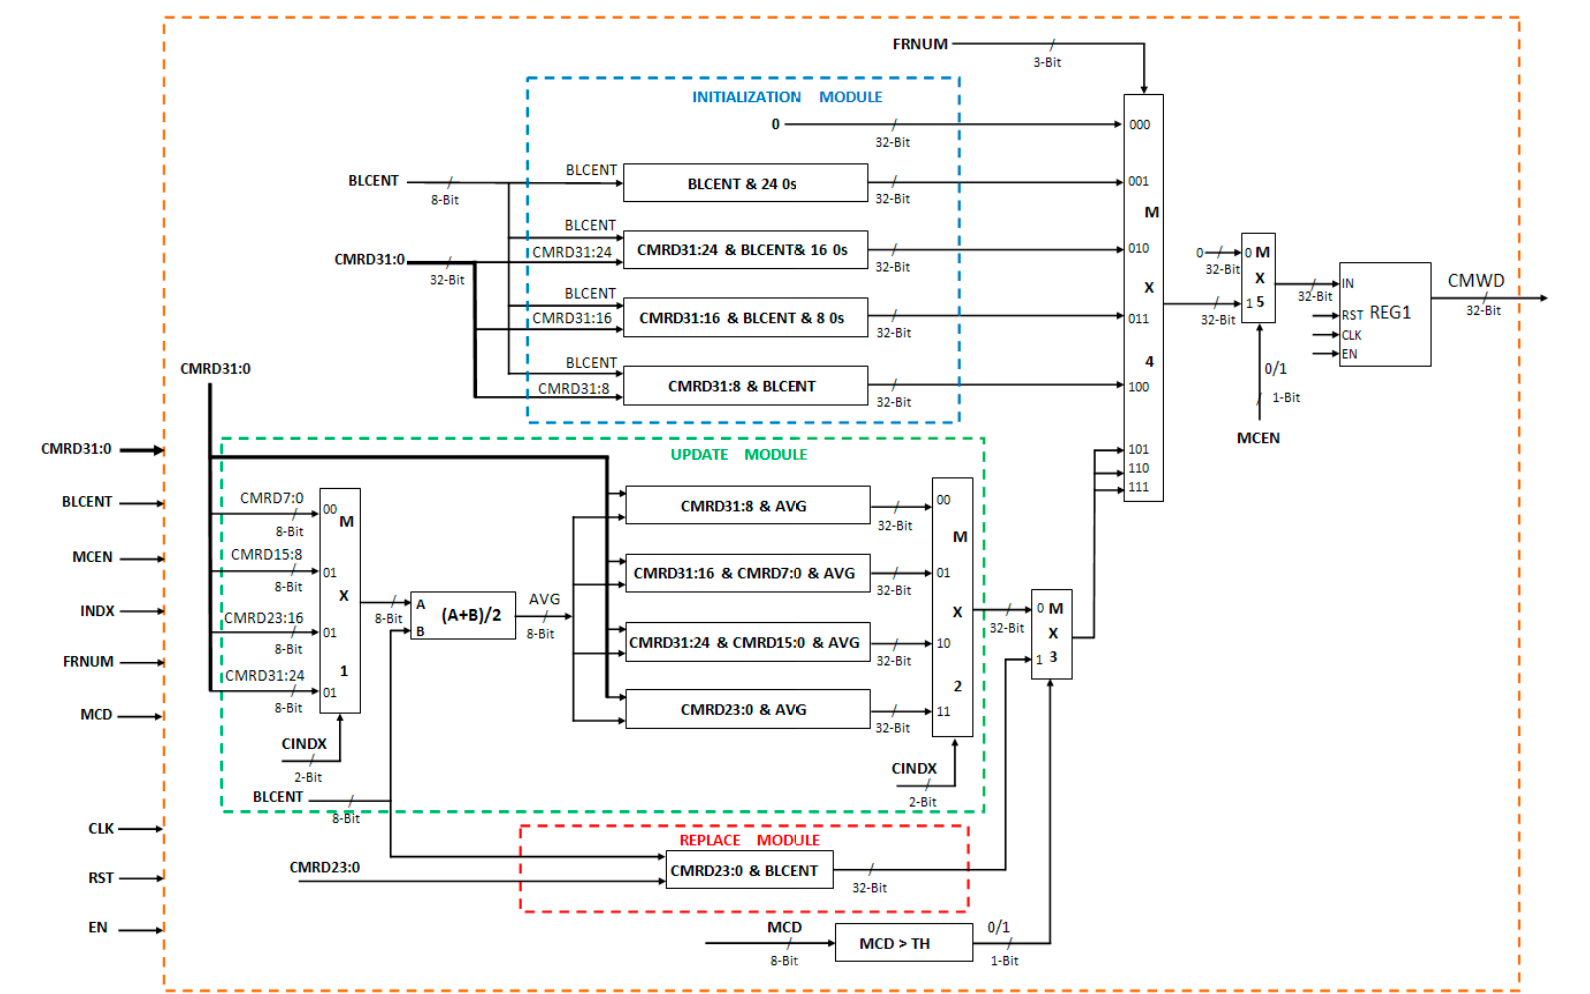
Figure 15. Proposed VLSI architecture for cluster initialization, updating, and